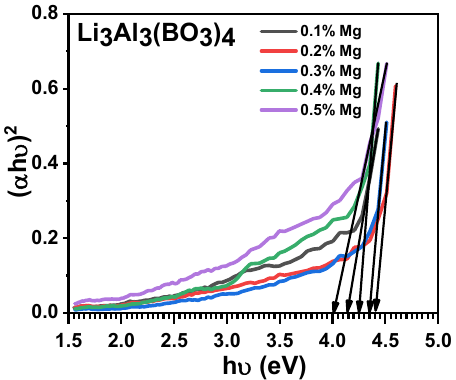
Figure 5. The energy band plot for the different concentrations of magnesium-doped lithium alu- minium borate.